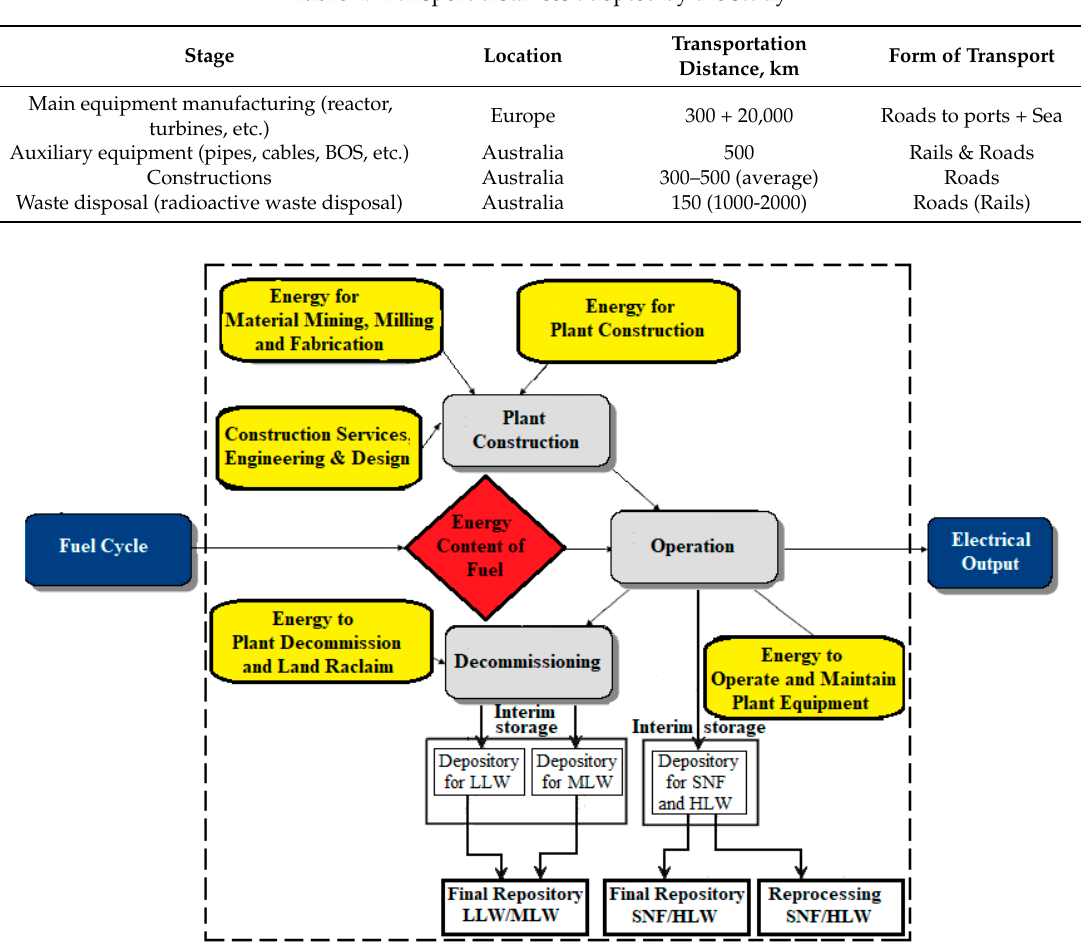
Figure 2. Processes for the nuclear power generation cycle adopted for this part of the study (The processes outside of dashed lines are out of scope of the study).